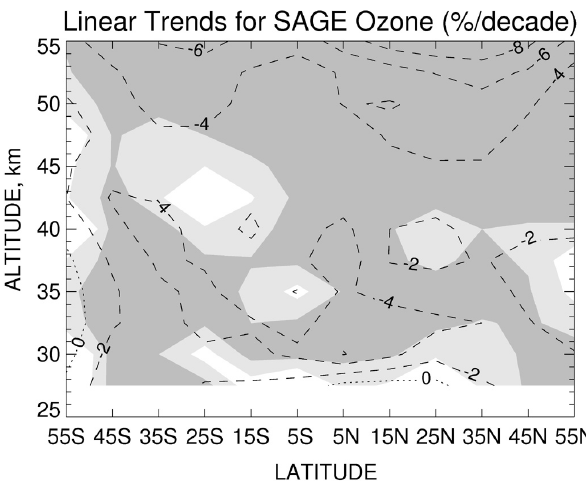
Fig. 8. Contour plot of the linear trend terms (in percent per decade) from the MLR models for the SAGE II ozone data of 1991 to 2005. Contour interval is 2%/decade. Dashed contours denote negative trends, and the dotted contour is where the trends are zero. Darker shading denotes where CI > 90% for the trends; lighter shading has 70% < CI <